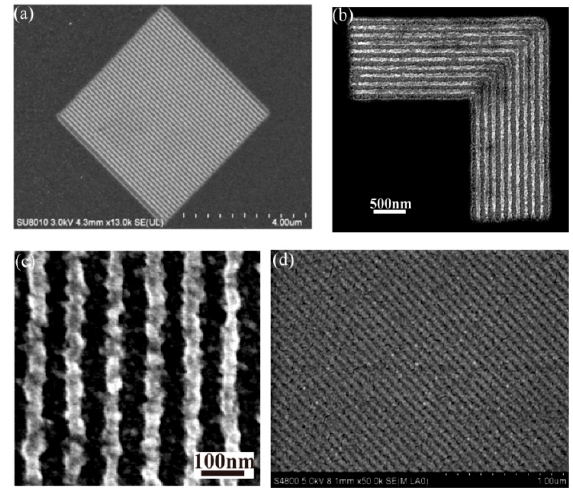
Figure 32. SEM picture of ( a ) 60 nm resolution with 120 nm air working distance under k x ,inc = 1.5 k 0 , ( b ) 50 nm resolution with 50 nm air working distance under k x ,inc = 1.5 k 0 , ( c ) 45 nm resolution with 20nm air working distance under k x ,inc = 1.5 k 0 , ( d ) 32 nm resolution with 40 nm air working distance under k x ,inc = 2.5 k 0 . Reproduced from [25], Copyright © 2015,